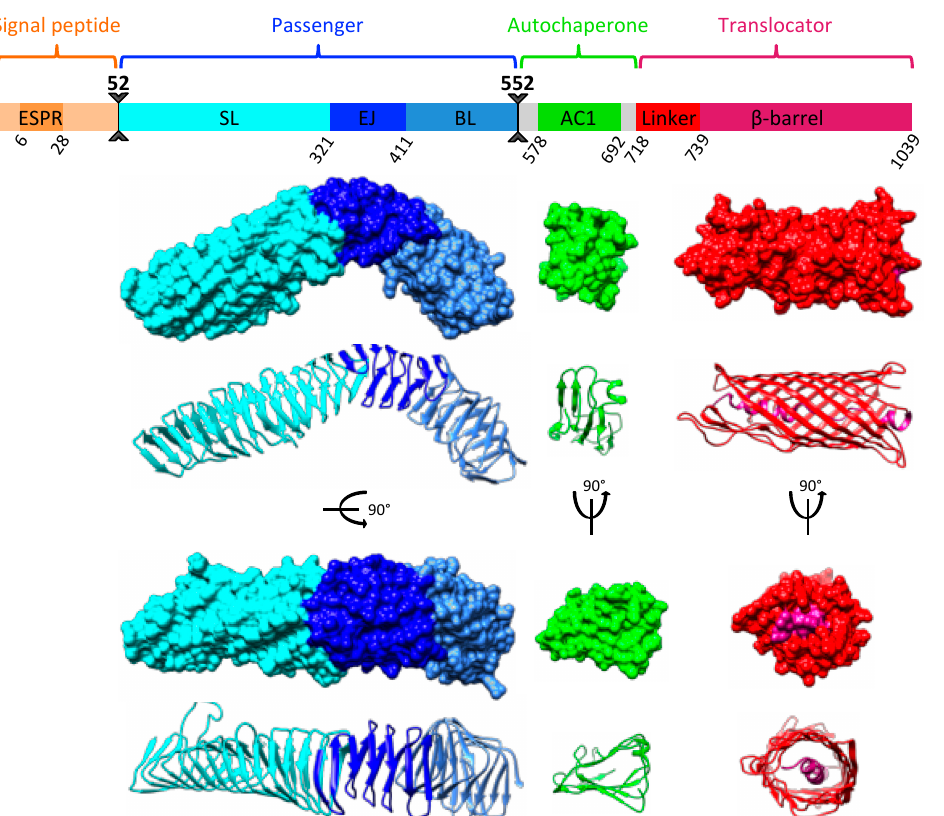
Figure 1. Modular organisation of the SAAT Ag43. The Ag43 C3 from UPEC CFT073 is presented. It is composed of an N-terminal SP exhibiting a conserved ESPR (IPR024973), a passenger domain corresponding to the effector region responsible for the autoaggregation function, a structurally conserved AC1 domain involved in folding, and a C-terminal translocator comprising a α -helical linker region and a β -barrel. The SP is processed between amino acid position 51 and 52 and the passenger is cleaved off from the AC1 and translocator regions between amino acid 551 and 552. The 3D structures are given as surface (upper part) and ribbon diagrams (lower part), which were generated from UCSF Chimera [19]. The passenger and AC1 correspond to the resolved structure of Ag43 C3 from UPEC CFT073 (PDB: 4KH3, 7KOB) [20,21], whereas the translocator was modelled with Phyre2 [22] with the translocator from AIDA-I (PDB: 4MEE) [23] used as a template.